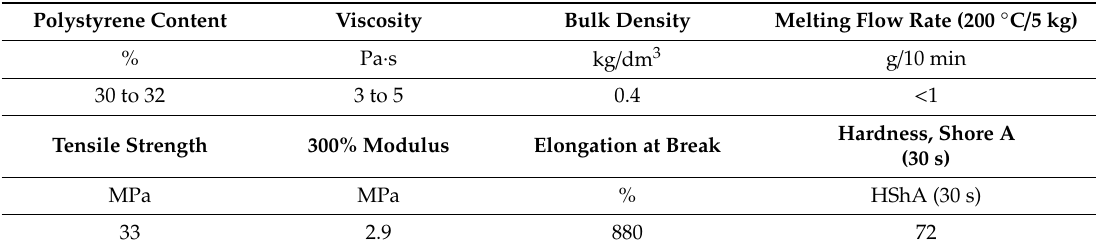
Table 2. Properties of styrene-butadiene-styrene copolymer KRATON TM D1101 A